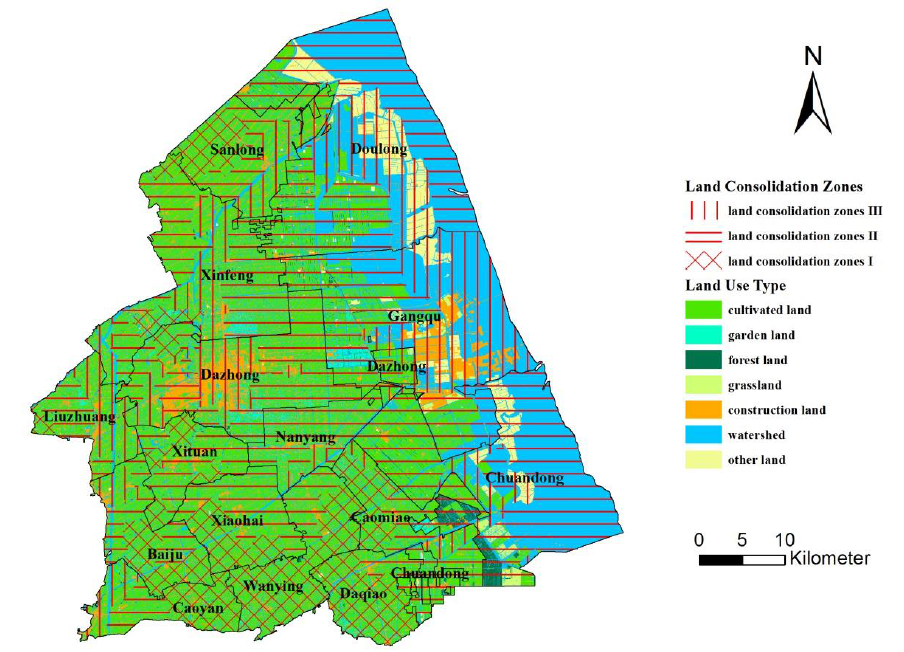
Figure 4. Land consolidation zoning map.